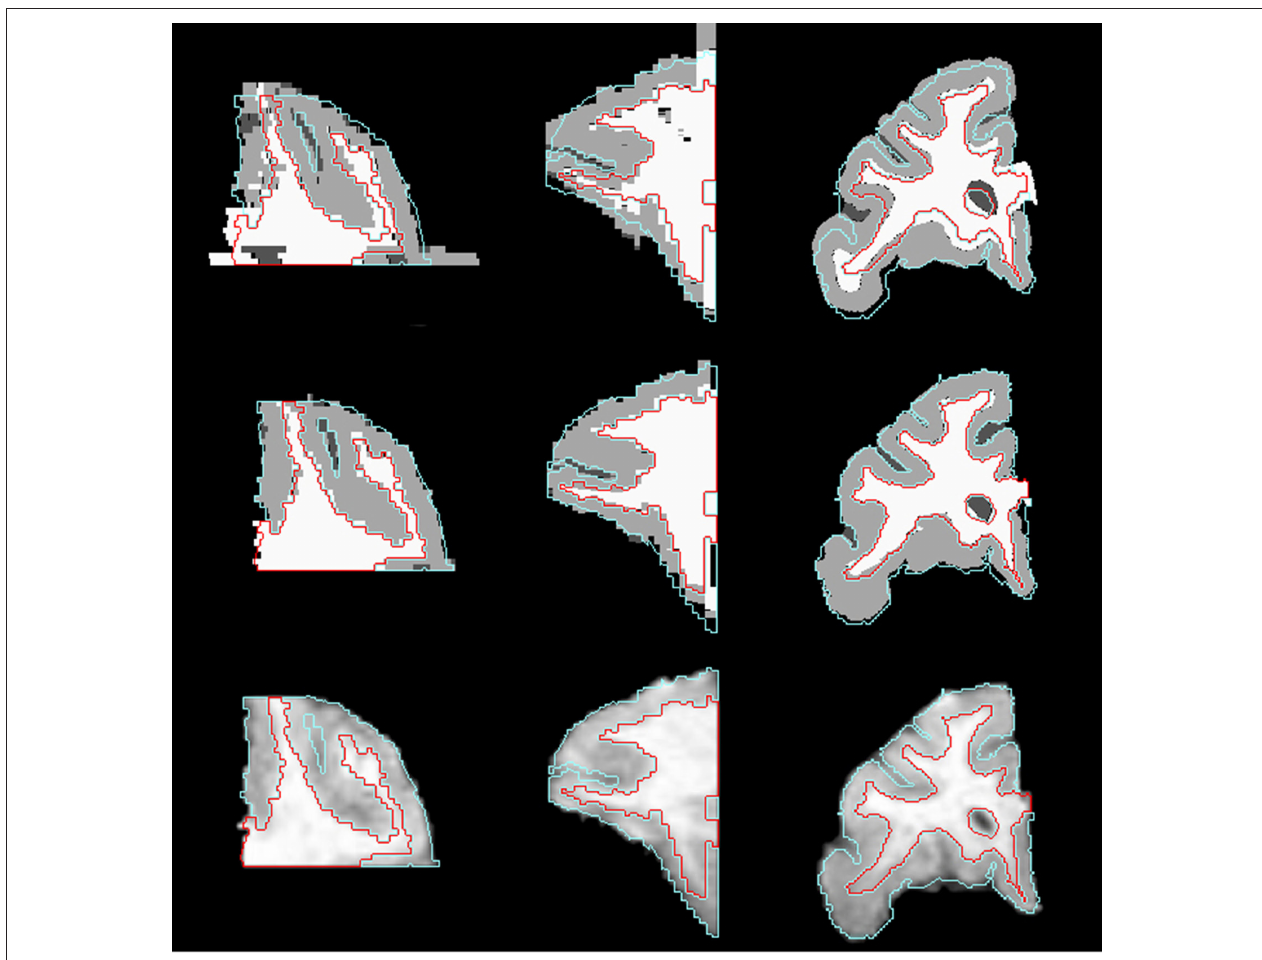
the GM/CSF boundaries (cyan) and the WM/GM boundaries (red) defined in the MRI volume are overlaid to illustrate the improvement of registration accuracy with LDDMM.